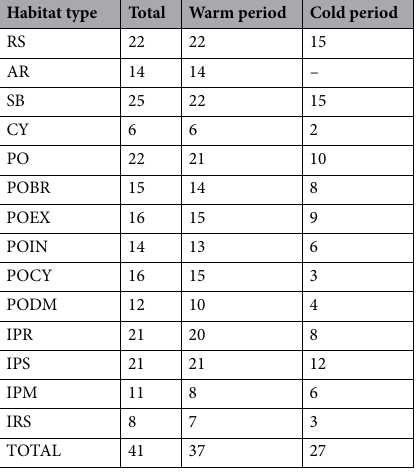
Table 4. Total number of fish taxa recorded in the different juvenile habitats of shallow coastal areas, and during the warm (summer 2014) and cold (spring 2015)